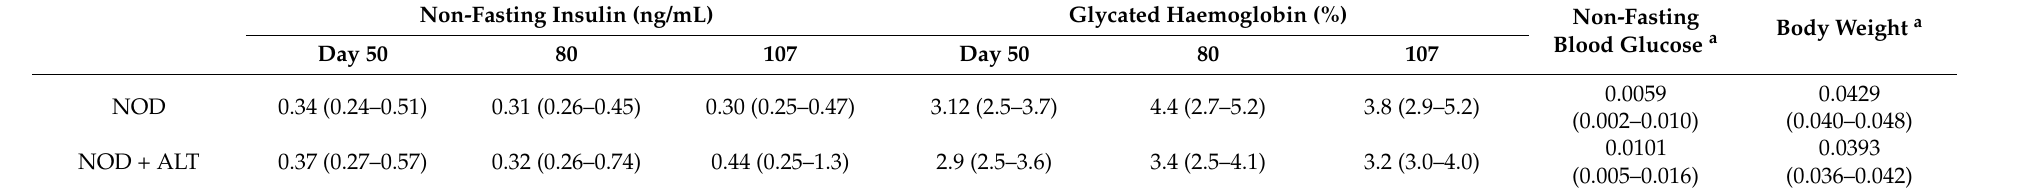
Table 2. Biochemical parameters in pre-diabetic NOD mice following short term AGE lowering therapy. Female NOD ShiLt (NOD) mice from day 50 to 100 were untreated or treated with the AGE lowering therapy alagebrium chloride (ALT, 1 mg/kg/day, s.c). Non-fasting insulin concentrations and glycated haemoglobin (%) at baseline (day 50), after 30 days of treatment (day 80) and 7 days after cessation of therapy (day 107) are reported as median (IQR). Time courses were analysed using a mixed-effects model with Sidak post-hoc correction for multiple comparisons. a Non-fasting blood glucose concentrations and body weight are reported as slopes from linear regression (95% CI) across the study period until the end of the study period (day 250 of